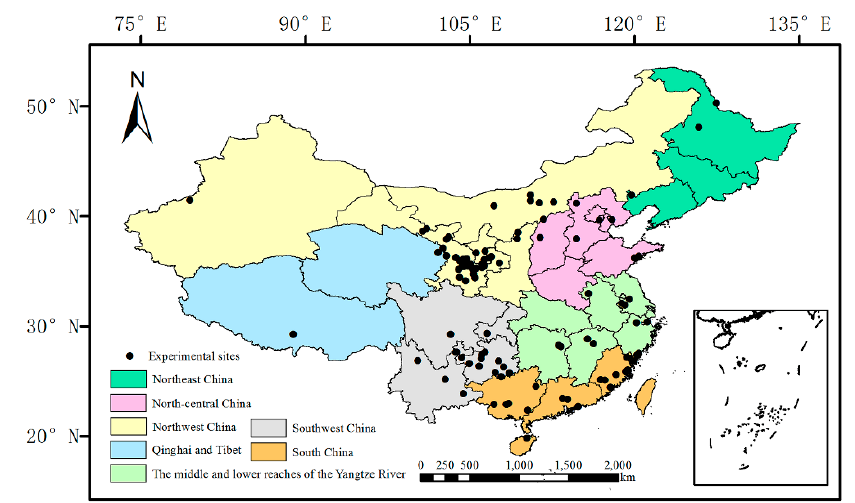
Figure 1. Location of field experiments included in this meta-analysis.